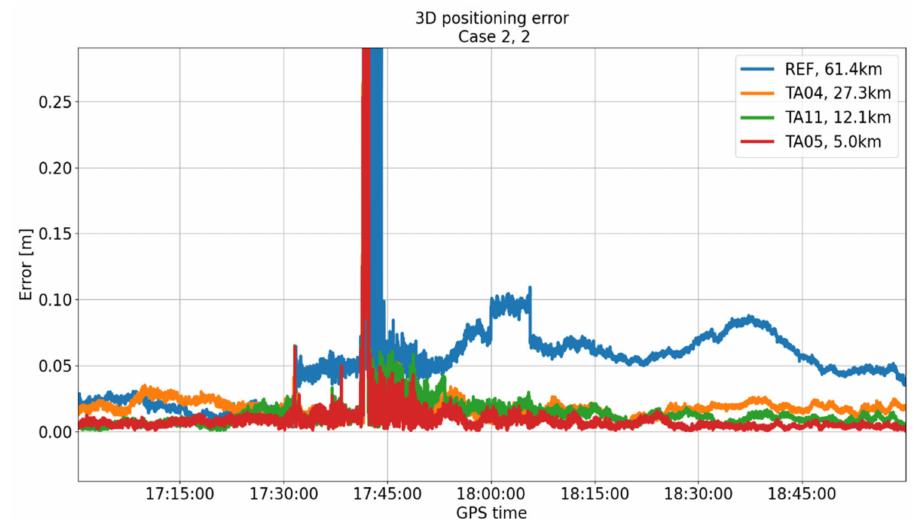
Figure 13. 3D positioning error for an entire 2-h span from 17:00 to 19:00 including the jamming incident from Case 2. It is seen that the very long baseline does not manage to fully recover within this